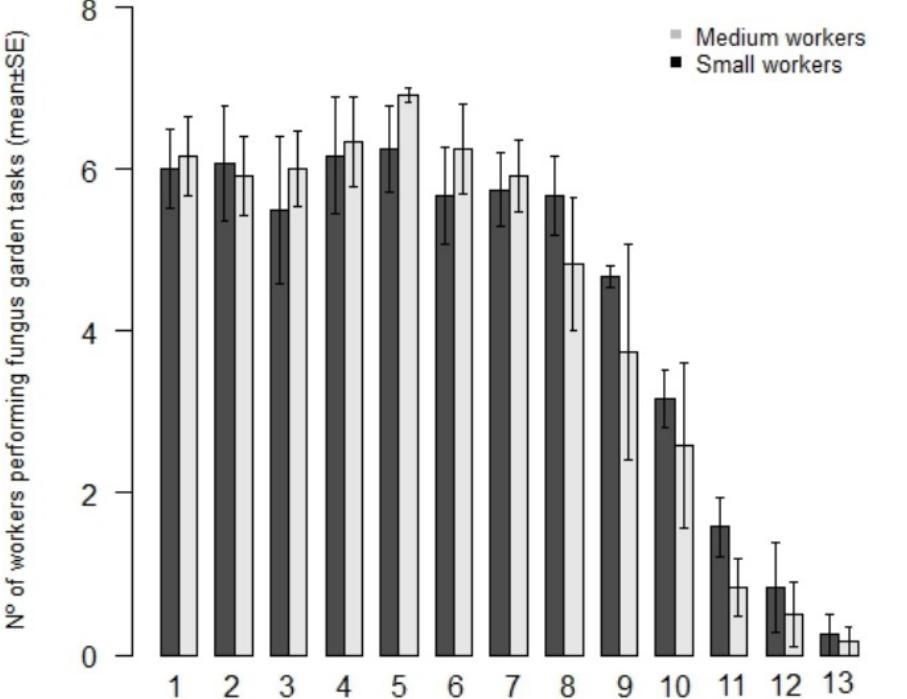
Fig 1 . Number of tasks occurrence within the fungus garden (garden, offspring and queen care) each week by medium and small-sized workers (mean ± SE).